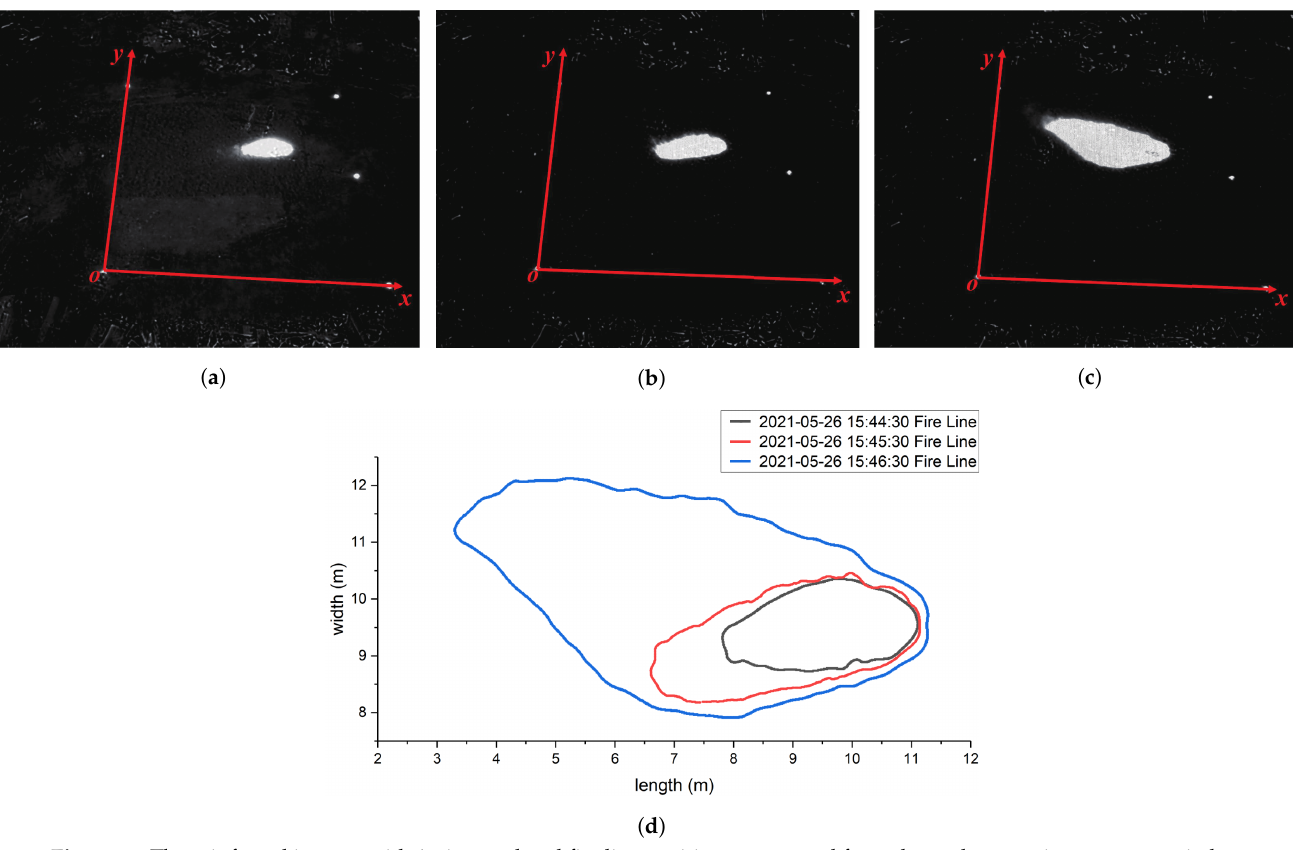
Figure 2. Three infrared images with 1 s interval and fire line positions computed from them, the experiment was carried out on 26 May 2021. ( a ) The infrared images captured at 15:44:30. ( b ) The infrared images captured at 15:45:30. ( c ) The infrared images captured at 15:46:30. ( d ) Fire line positions computed from infrared images using perspective transformation. Table 3. Statistical analysis results of 13 data sets. “Aver” means the average value; “Stan Devi” means standard deviation; “Confi Inter” means confidence